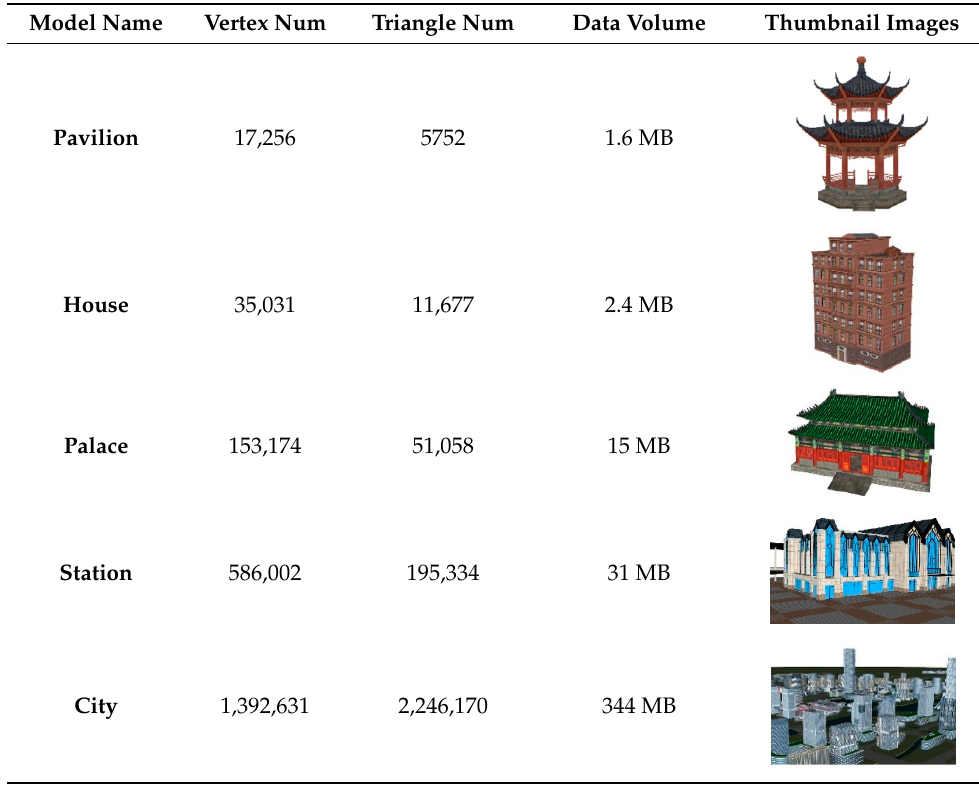
Table 1. Experiment data.